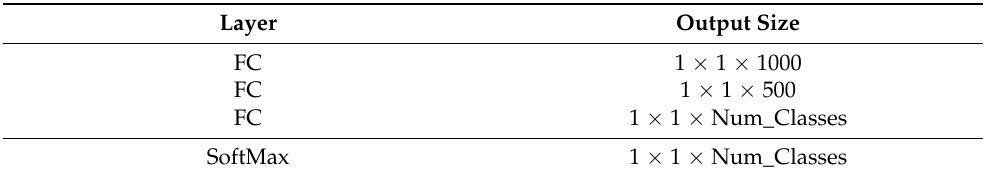
Table 8. Multimodal fusion model architecture (Num_Classes means the number of classes, and FC means fully connected